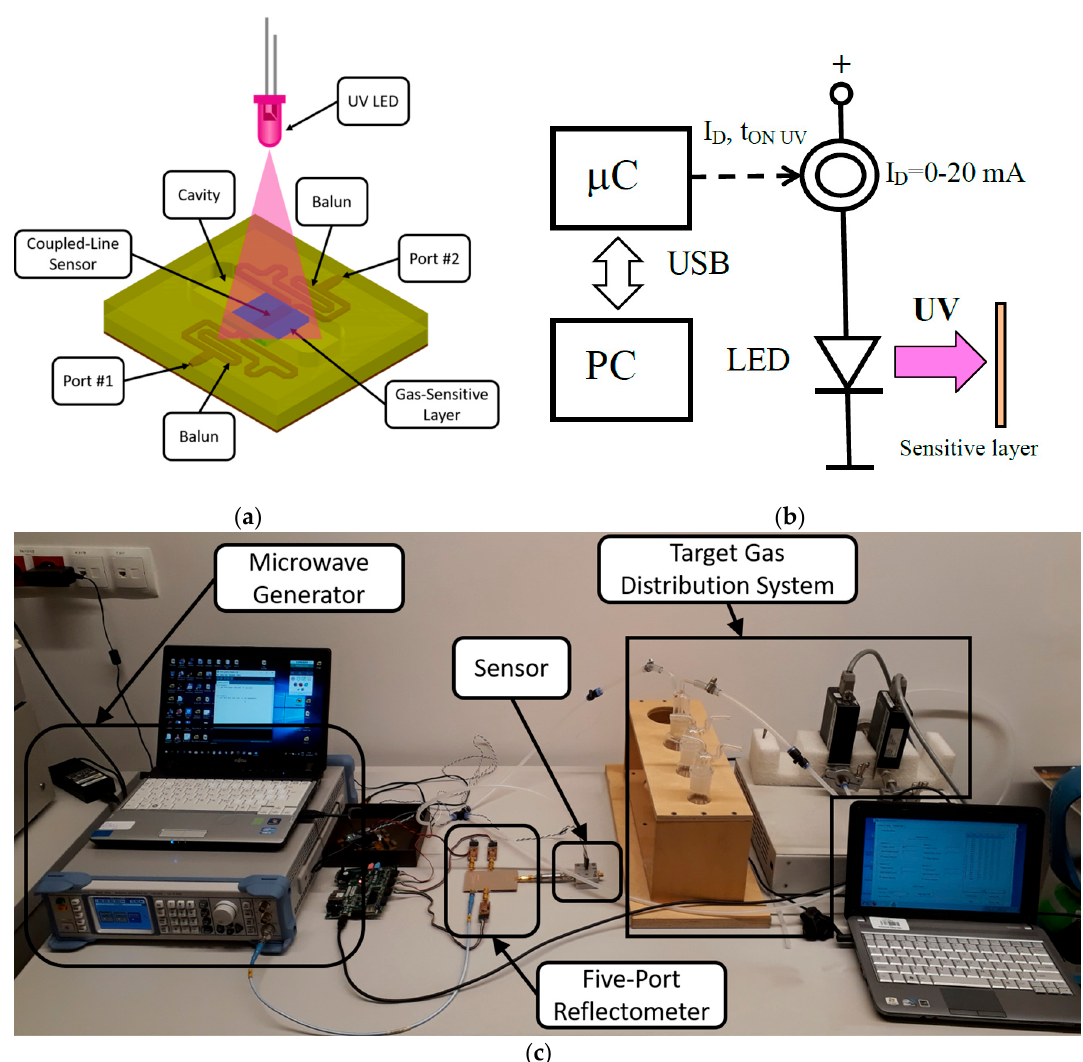
Figure 1. The microwave gas sensor system: ( a ) sketch of the microwave gas sensor; ( b ) sketch of the UV illumination system; ( c ) photo of the gas-sensing system.